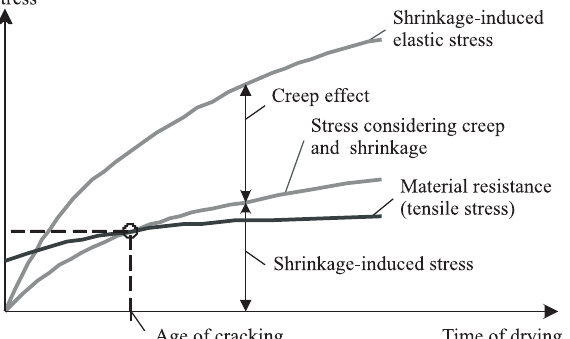
Krampe-Harex KP 35/1.95